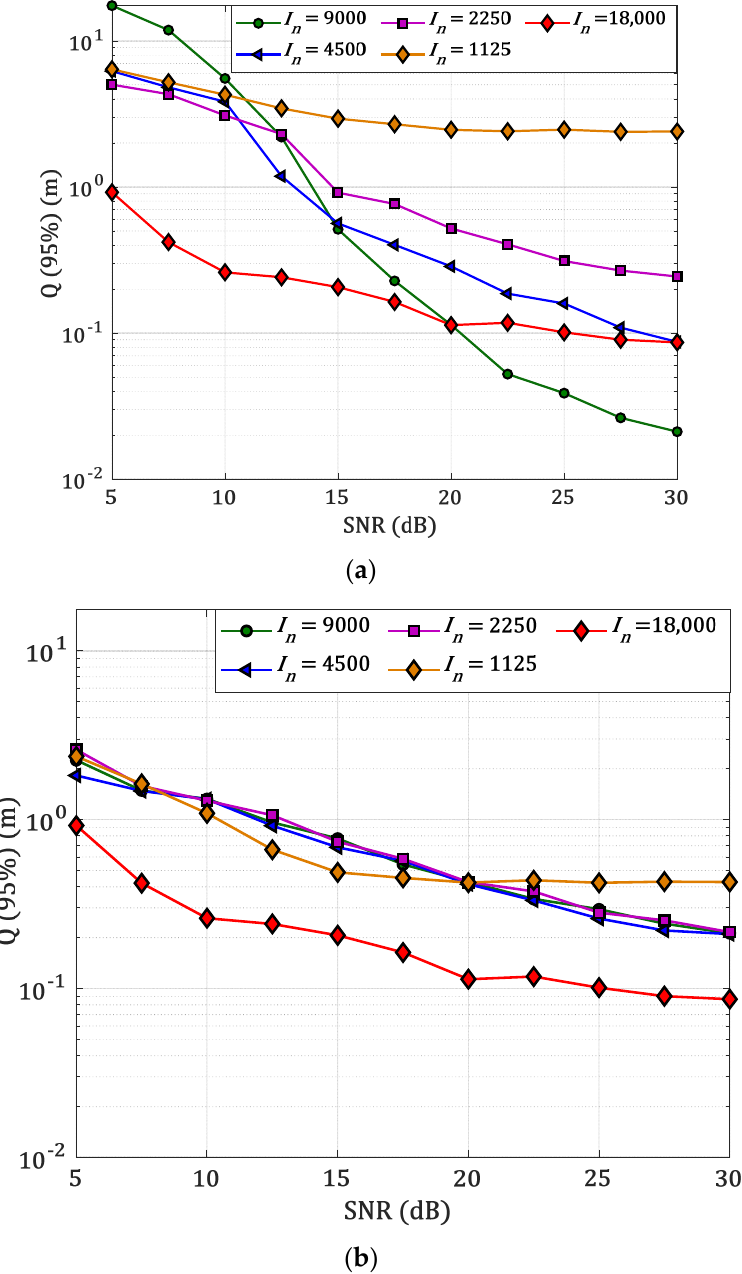
Figure 11. The measured 95% quantile function for a different number of samples in the input with: ( a ) RS; and ( b ) US.